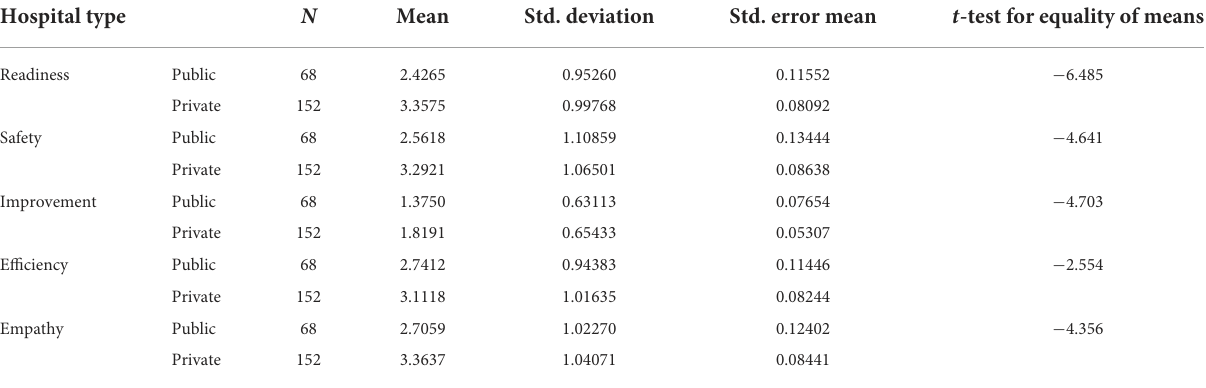
TABLE 4 Descriptive Statistics of HEALTHQUAL dimensions according to the type of hospital (public vs. private).